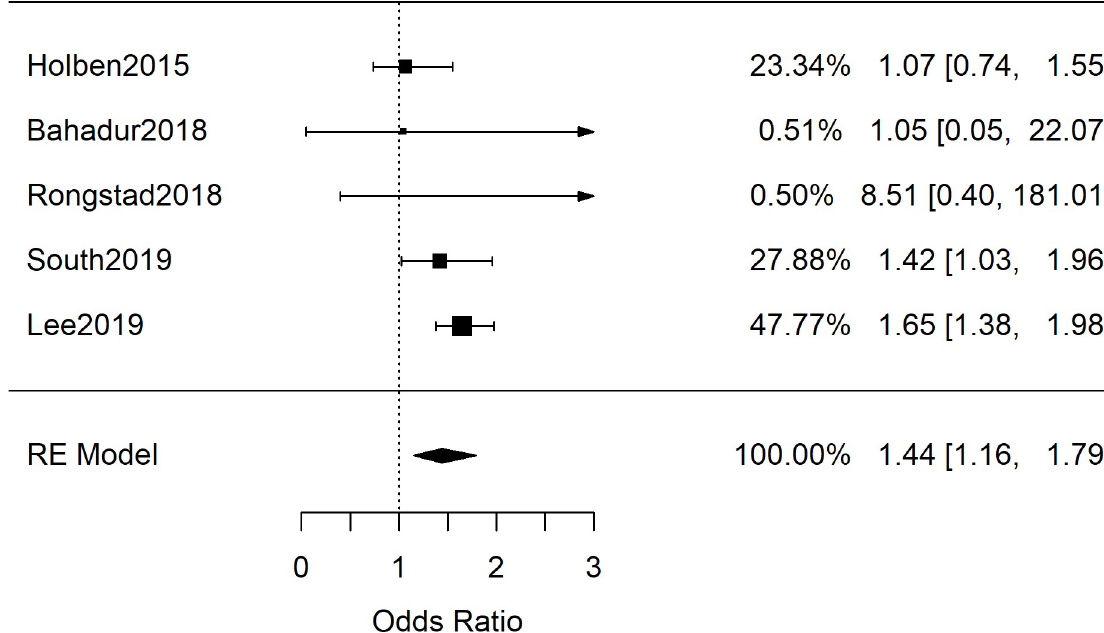
Fig 6. Meta-analysis of pediatric studies investigating food insecurity and hypertension. Shown are data from the 5 pediatric odds ratio studies showing variable results but a significant, combined odds ratio of 1.44 [95%CI: 1.16, 1.79; n = 19,038; Q ( df = 4) = 5.7; I 2 = 30%]. Two studies involved medical records inspection of diagnosed hypertension [61, 62], two involved mixed methods for hypertension diagnoses [63, 64], and one involved direct BP measurements [60].